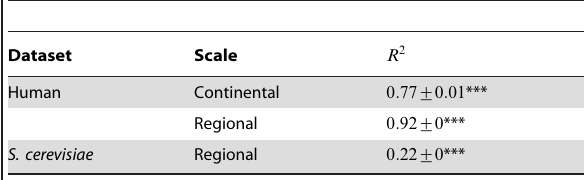
Table 1. R 2 values calculated for two experimental datasets of human and S. cerevisiae microsatellite